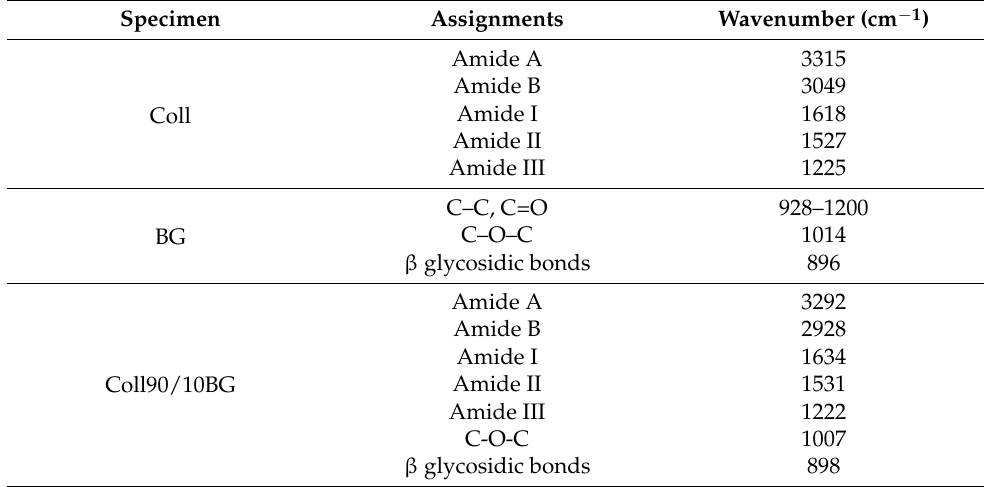
Table 1. Assignments of the major frequencies of collagen, β -glucan, and collagen/ β -glucan